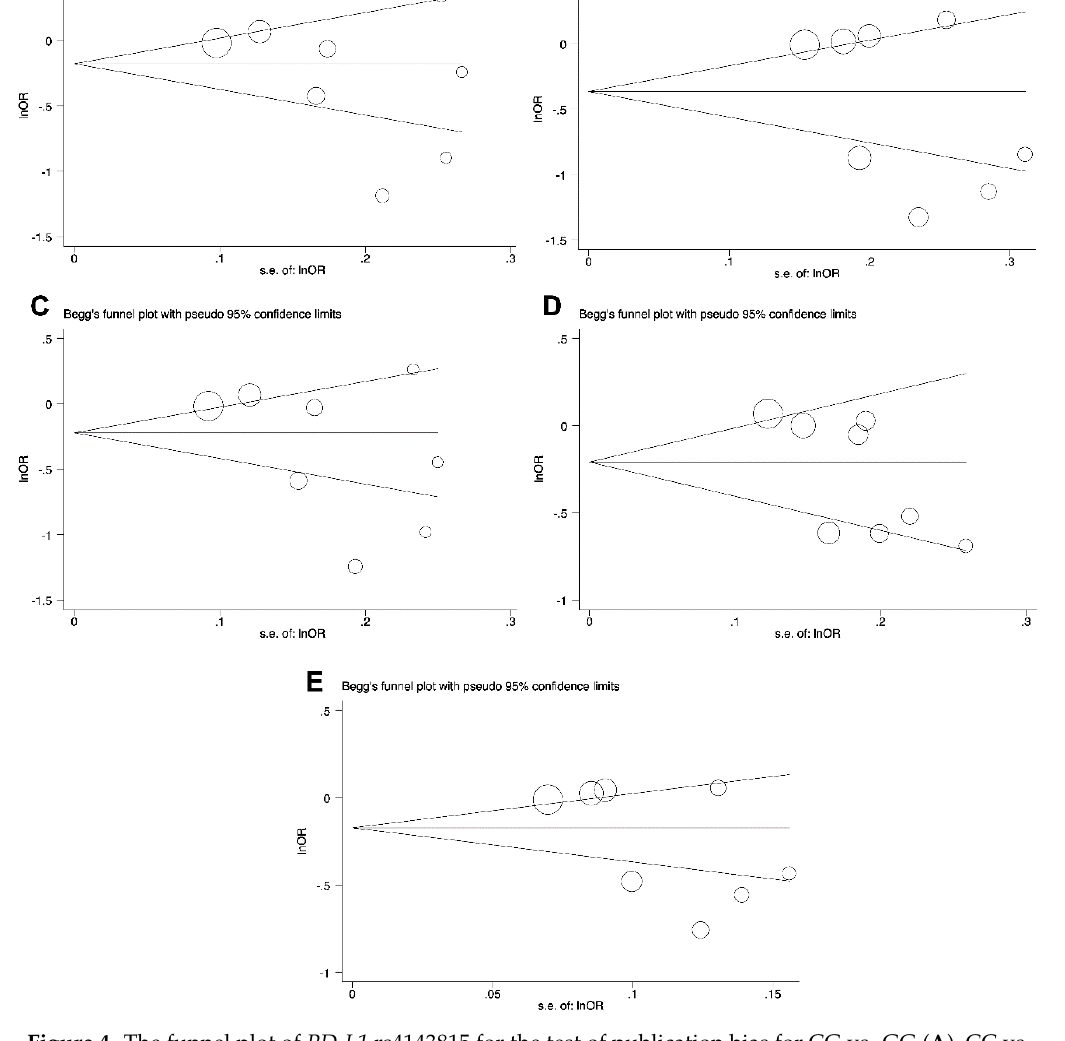
Figure 4. The funnel plot of PD-L1 rs4143815 for the test of publication bias for CG vs. GG ( A ), CC vs. GG ( B ), CG + CC vs. GG ( C ), CC vs. CG + GG ( D ), and C vs. G ( E ).